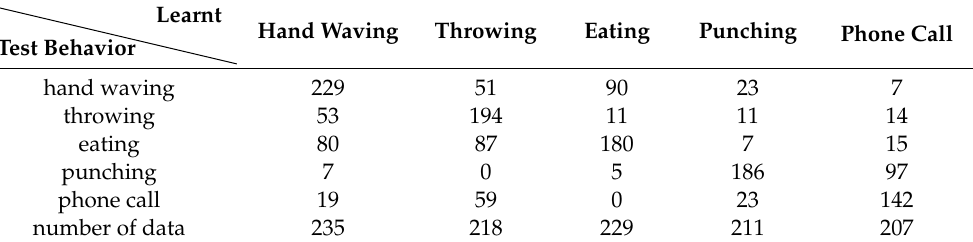
Table 4. Confusion matrix of GRU-based DHN.